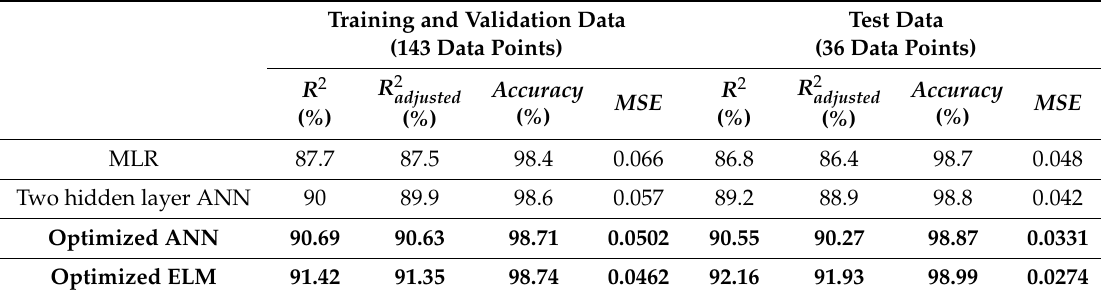
Table 1. Comparison results of the proposed prediction models to those proposed and developed in [43]. MLR: multivariate linear regression model.